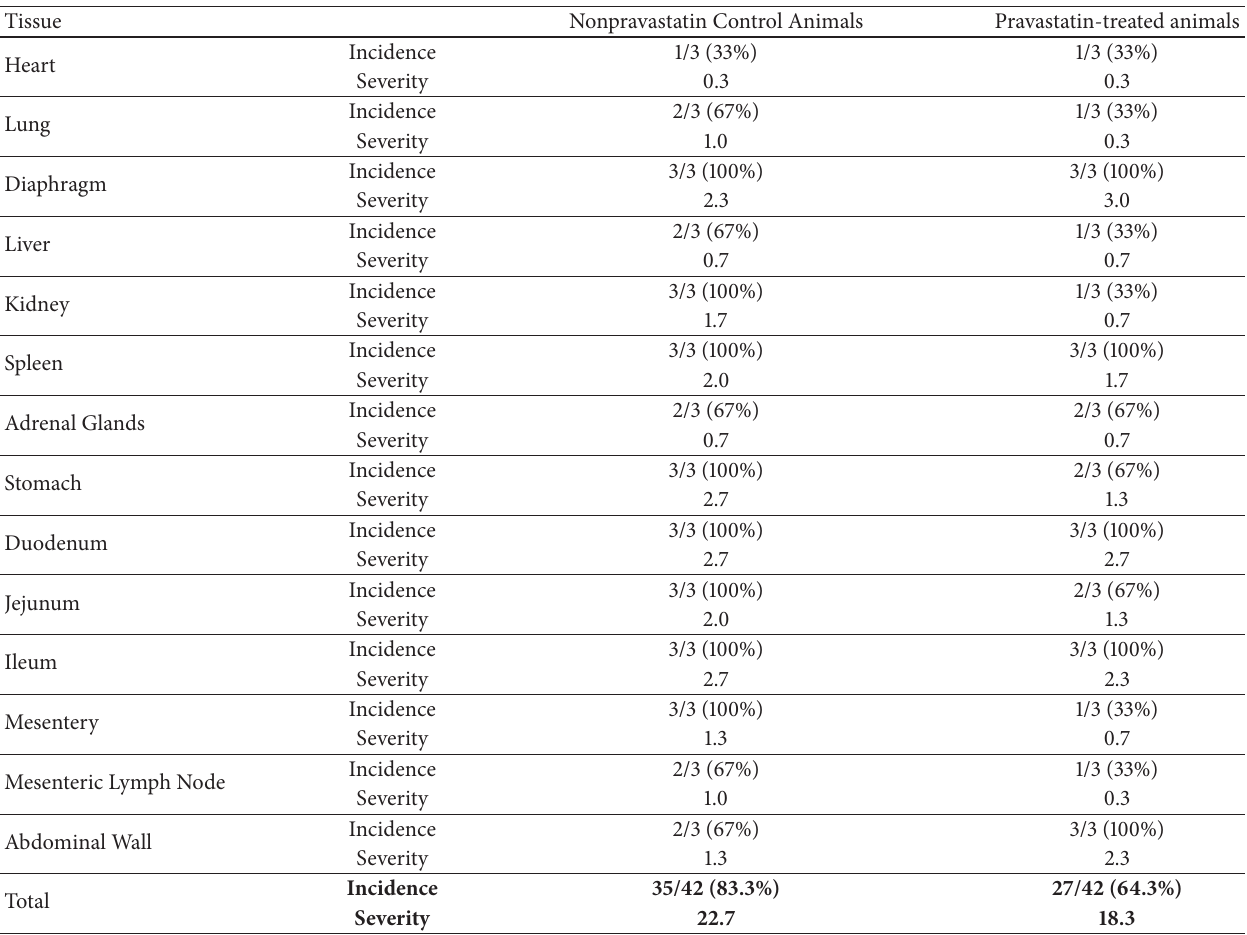
Table 2: Histopathology